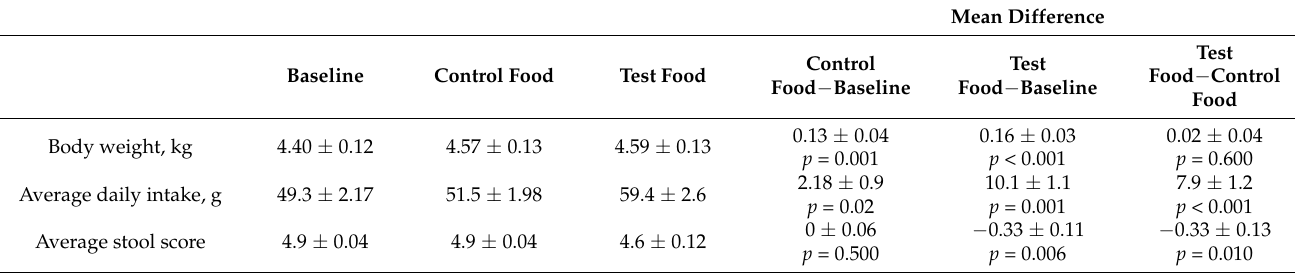
Table 3. Body weight, intake, and stool